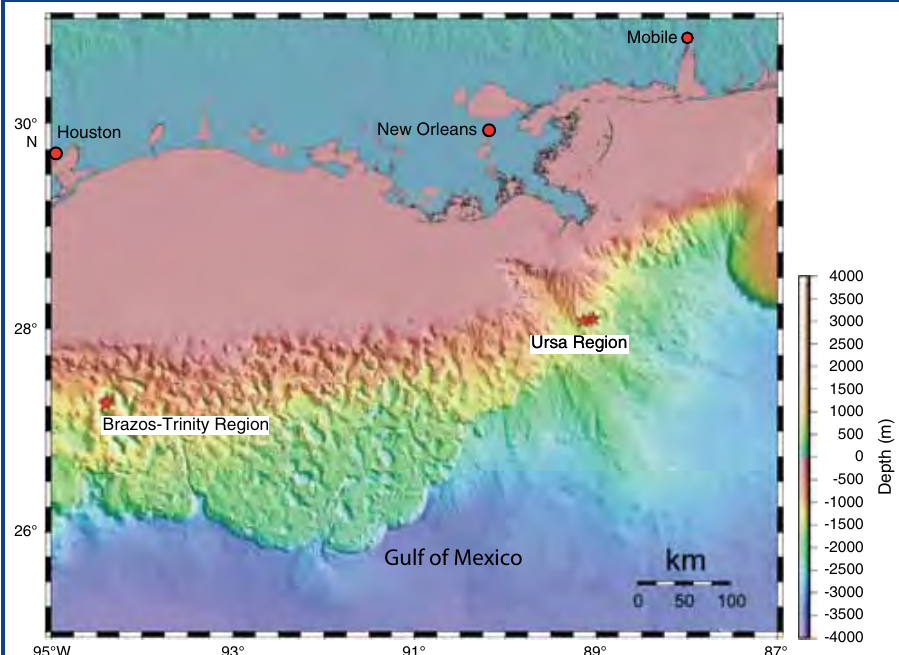
Figure 2. Bathymetric image of continental slope of Gulf of Mexico. Drilling took place in Brazos-Trinity (reference sites) and Ursa (overpressured sites) regions.